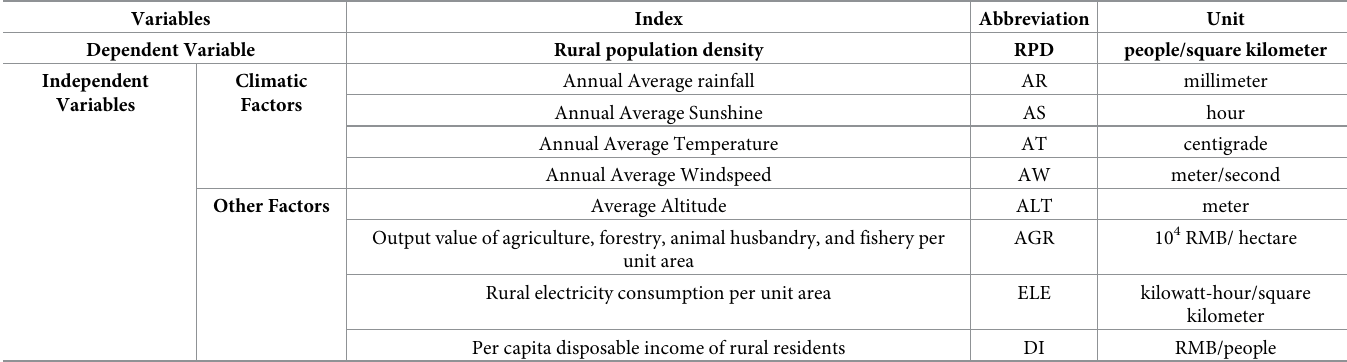
Table 2. Index system of the rural population distribution.